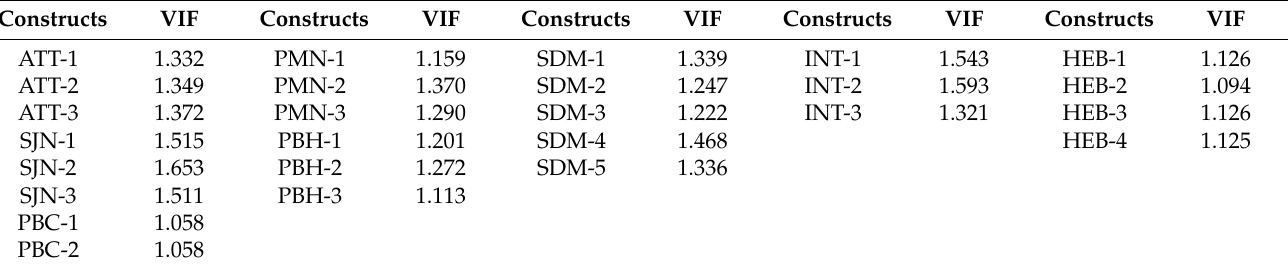
Table 4. Collinearity assessment for the model.